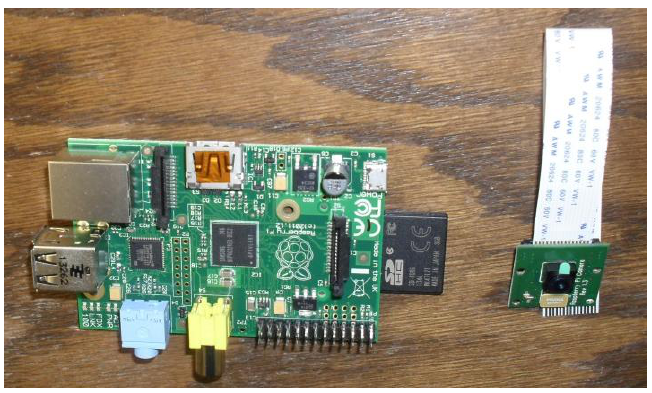
Figure 5. Raspberry Pi and camera.